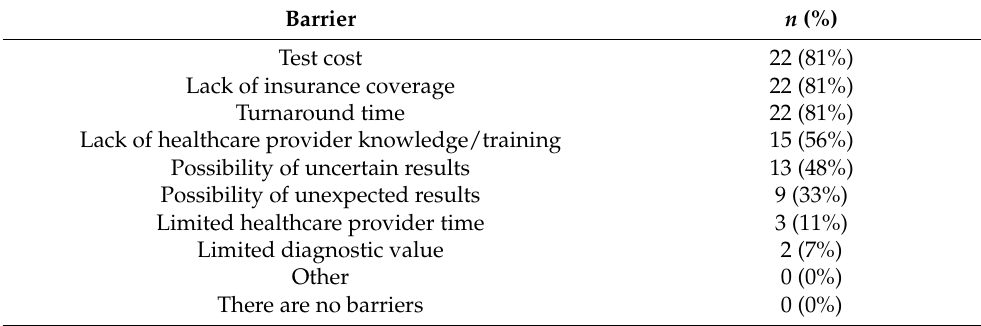
Table 2. Perceived barriers to implementation of genome sequencing in the NICU setting.